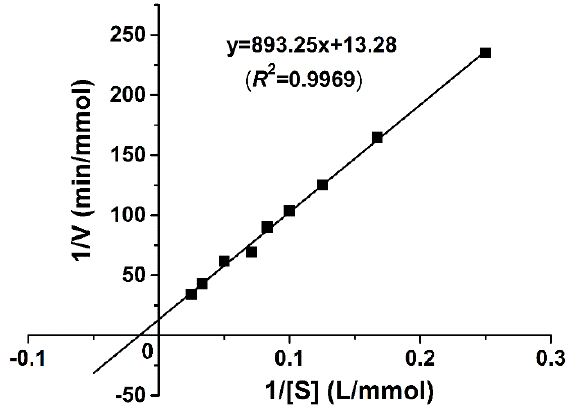
Figure 4. Lineweaver-Burk plot of purified GWC kinetics. The y -axis represents the reciprocal of the reaction rate and the x -axis is the reciprocal of the substrate concentration. The reactions were carried out at the final fixed GWC concentration of 1 µ g/mL and various H 2 O 2 substrate concentrations ranging from 4 to 40 mM at 75 ◦ C with pH 9.0. Each data point is obtained from an average of three independent kinetic measurements. The solid line is the trend-line of the linear regression, with a correlation coefficient of R 2 = 0.9969.